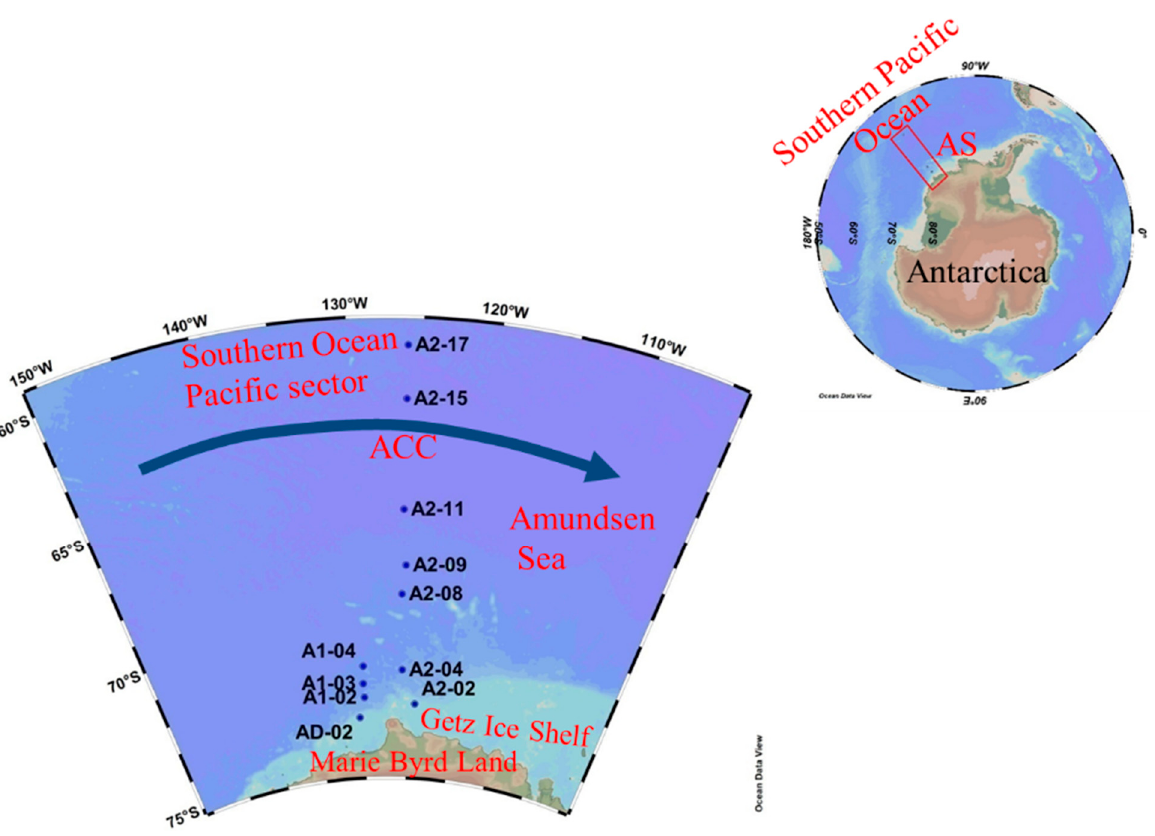
Figure 1. The sampling locations in the Amundsen Sea, Antarctica. The eastward-flowing Antarctic Circumpolar Current (ACC) is shown. Circumpolar Current (ACC) is